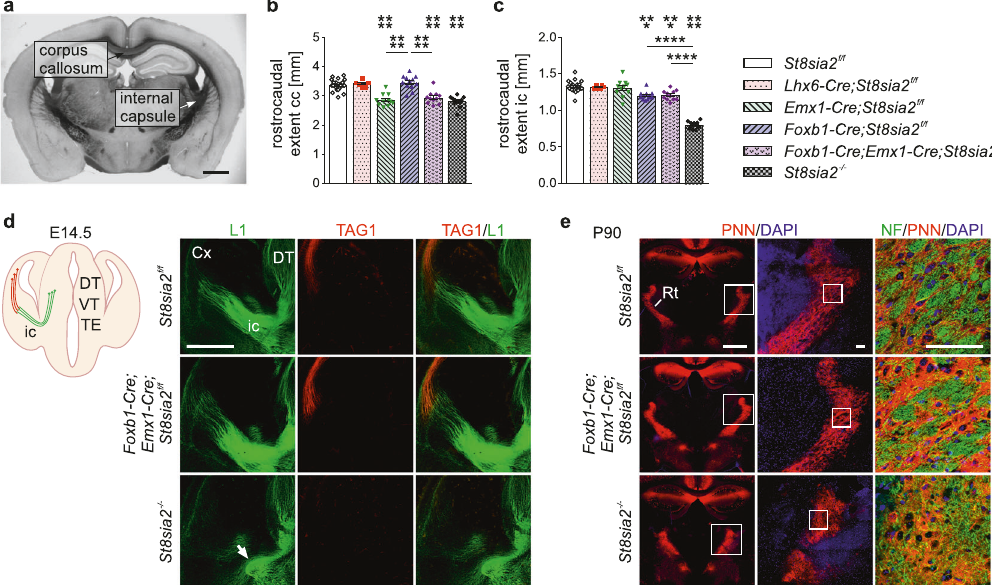
Fig. 1 De fi cits of thalamus-cortex connectivity in St8sia2 − / − mice are not reproduced by any of the cKO lines. a Representative image showing the corpus callosum and the internal capsule on a coronal brain section from a St8sia2 f/f mouse. b , c Rostrocaudal extent of the corpus callosum (cc) and the internal capsule (ic) for the indicated genotypes. Graphs show means ± SEM and individual data points of n = 24, 6, 11, 12, 11, and 11 St8sia2 f/f , Lhx6-Cre;St8sia2 f/f , Emx1-Cre;St8sia2 f/f , Foxb1-Cre;St8sia2 f/f , Foxb1-Cre;Emx1-Cre;St8sia2 f/f and St8sia2 − / − mice, respectively. One-way ANOVA indicated signi fi cant differences ( p < 0.0001; F 5,69 = 27.28 in b , F 5,69 = 88.33 in c ). Holm – Sidak ’ s post hoc tests were applied and signi fi cant differences for comparisons with St8sia2 f/f controls or between selected genotype groups are indicated (*** p < 0.001, **** p < 0.0001). d Scheme of thalamocortical (green) and corticothalamic axons (red), and immunolabelling with L1- (green) and TAG1- speci fi c antibodies (red) on coronal sections of brains from embryonic day (E) 14.5 mice of the indicated genotypes (DT, dorsal thalamus; VT, ventral thalamus; TE, thalamic eminence; ic, internal capsule). The white arrow points to deviating thalamocortical axons in the St8sia2 − / − embryo. e Labeling of perineuronal nets with Wisteria fl oribunda agglutinin (PNN, red) to visualize the reticular thalamic nucleus (Rt), and neuro fi lament staining of fi bers (NF, green) on coronal sections of brains from P90 mice of the indicated genotypes. Boxed areas highlight higher magni fi cation views in the following column. Scale bars, 1 mm in ( a ) and ( e ), left column, 500 μ m in ( d ), 100 μ m in ( e ), middle and right